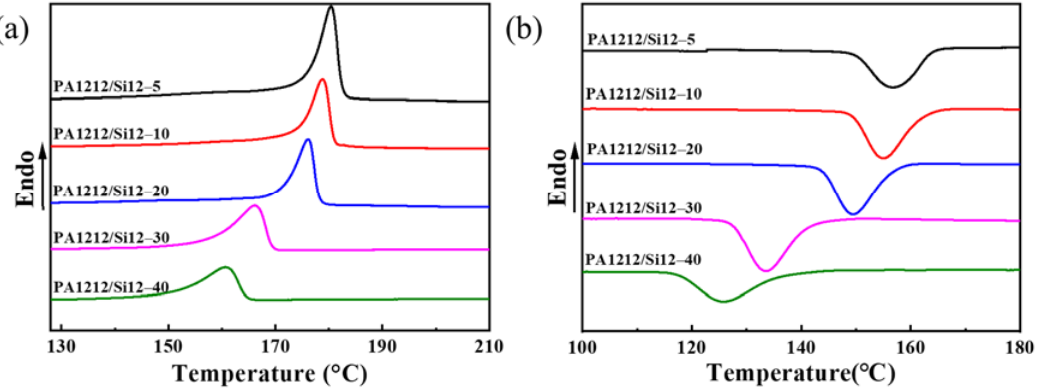
Figure 2. DSC curves of PA1212/Si12 copolymers during ( a ) the first cooling scan and ( b ) the second heating scan at 10 °C/min. Table 2. The thermal transition parameters of PA1212/Si12 copolymers.